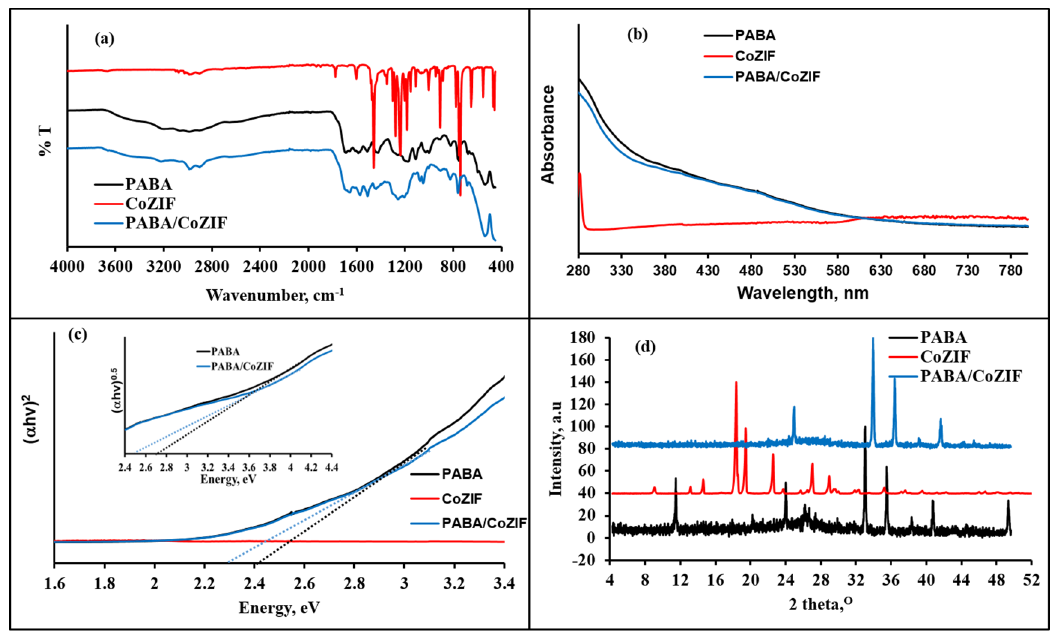
Figure 1. FTIR spectra ( a ); UV-Vis absorption spectra ( b ); Tauc plot for direct energy band gap ( c ) (inset: indirect energy band gap of PABA and PABA/CoZIF composite); and XRD patterns of synthesized PABA, CoZIF and PABA/CoZIF composite ( d ).